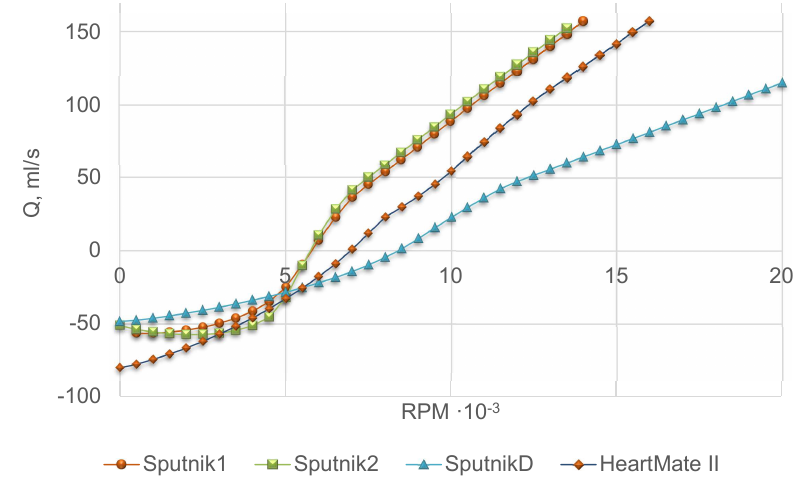
Figure 4. The minimum flow through the